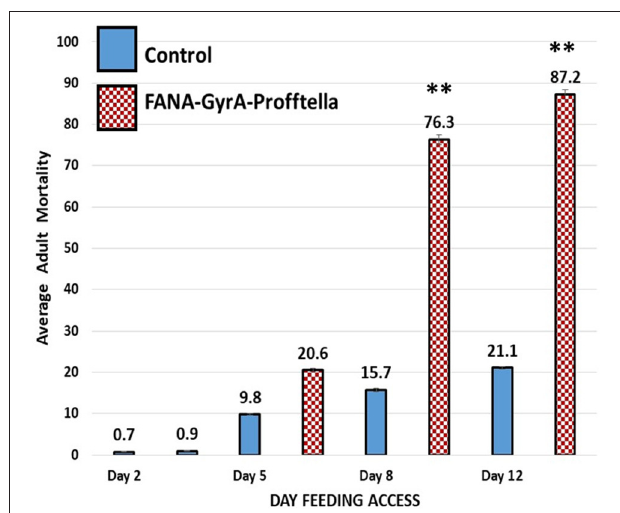
FIGURE 6 | Average adult psyllid mortality on FANA treated citrus seedlings. Mortality of adult psyllids fed on citrus seedlings treated with FANA-GyrA to Profftella , was significantly greater than the control groups on days 8 and 12. Psyllid mortality associated with feeding on control and FANA-GyrA plants was not significantly different on days 2 or 5, reaching average of 0.8% ( ± SE 0.10) between treatments on day 2, and 9.81% ( ± SE 0.33) and 20.6% ( ± SE 0.24) in the control compared to the FANA-GyrA, respectively, on day 5. Single factor ANOVA, F (1,34) = 397.9, p < 0.001, η 2 = 0.92, followed with Tukey post-hoc comparison of means ( P ≤ 0.01). Error bars represent ± SE of the mean from 18 biological replicates, from two technical replicates. Symbol ** signifies significantly different from control.